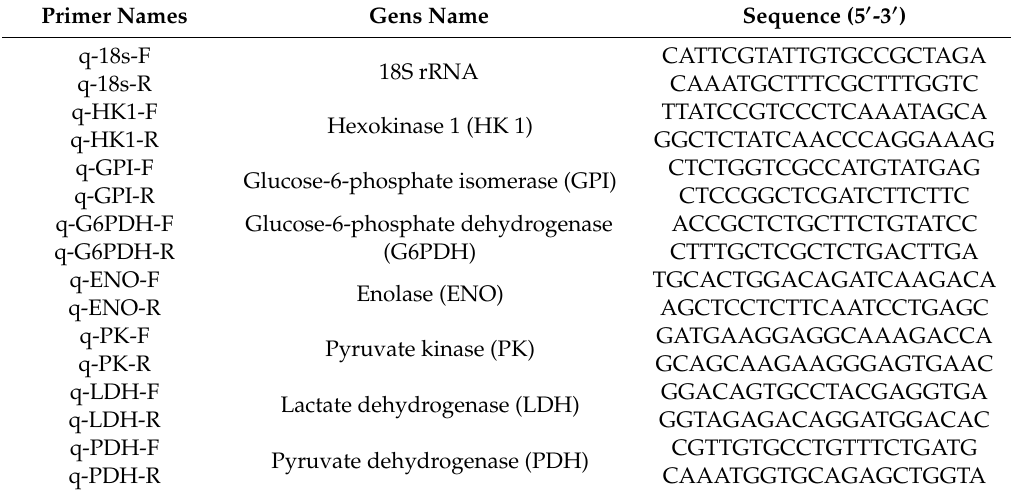
Table 1. Primers used in this